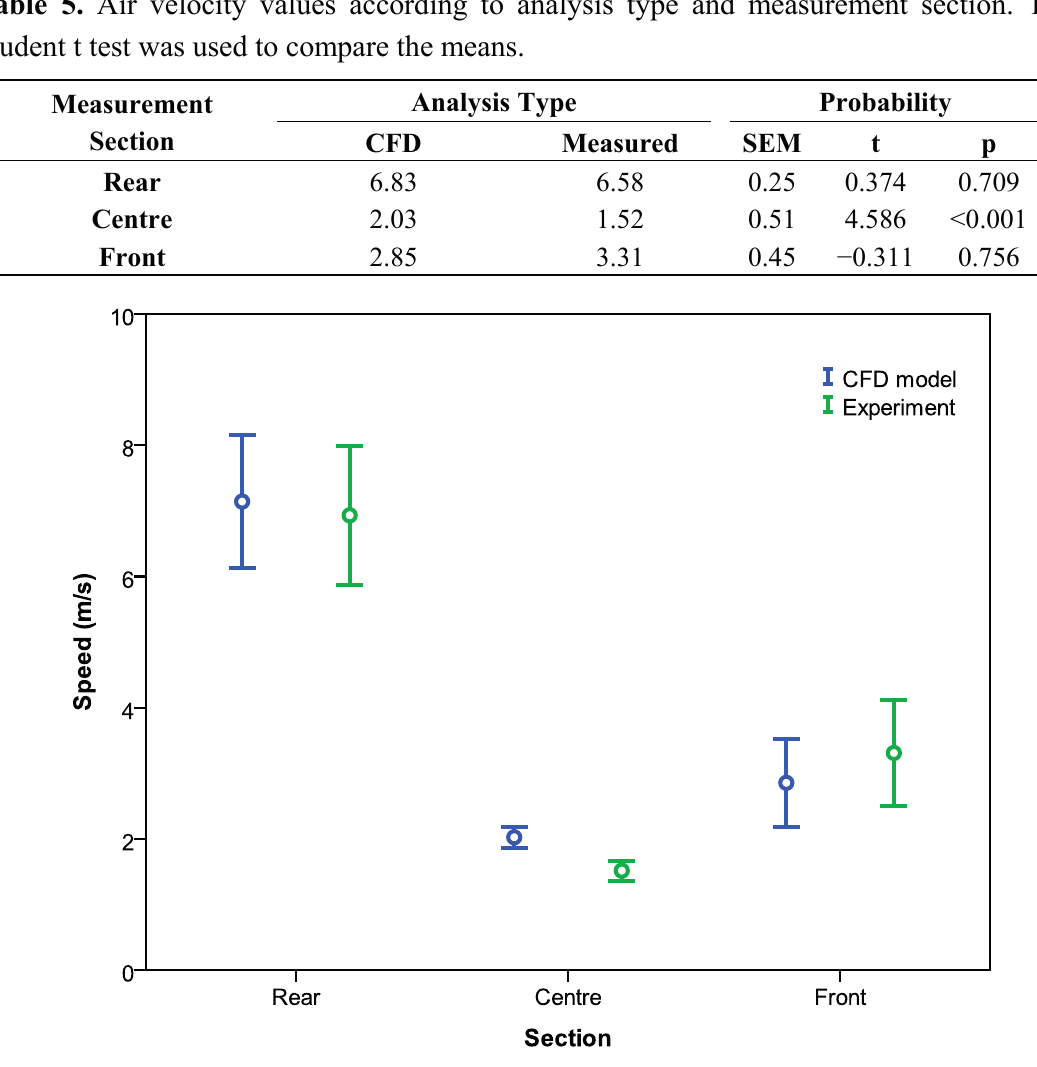
Figure 11. 95% confidence interval of means of air velocity values according to analysis type and measurement